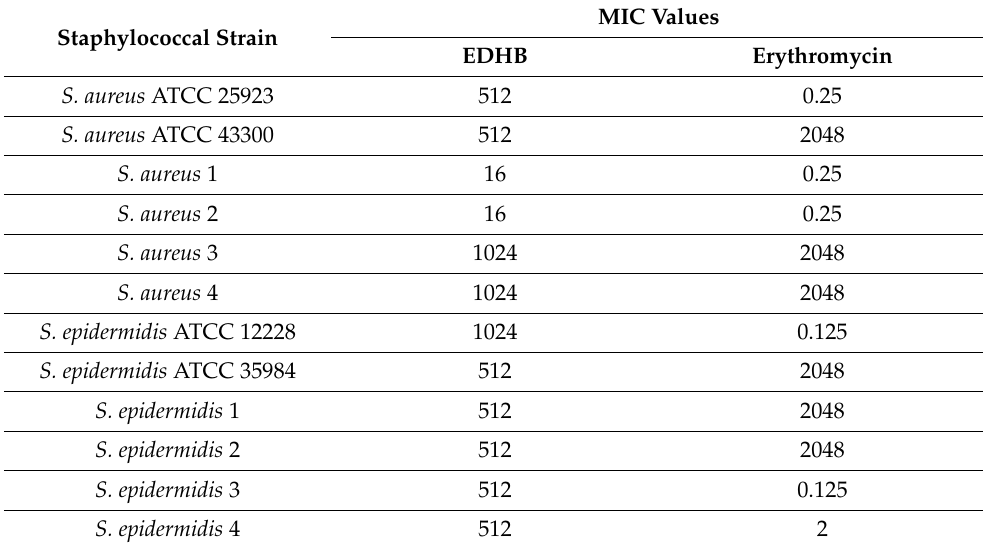
Table 2. The MIC values for staphylococcal strains in the second stage of the study. Staphylococcal Strain